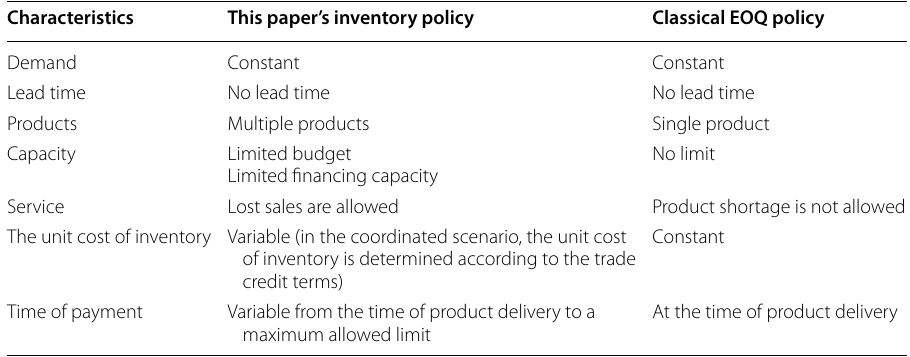
Table 2 Comparison between EOQ policy and inventory policy of the current paper